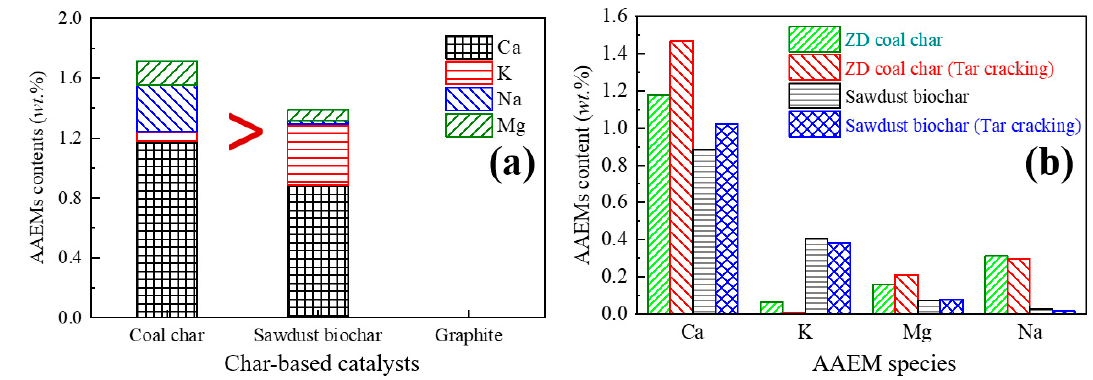
Figure 2. Alkali and alkaline earth metal species (AAEMs) contents in char-based catalysts: ( a ) Raw and ( b ) changes before/after tar reforming.